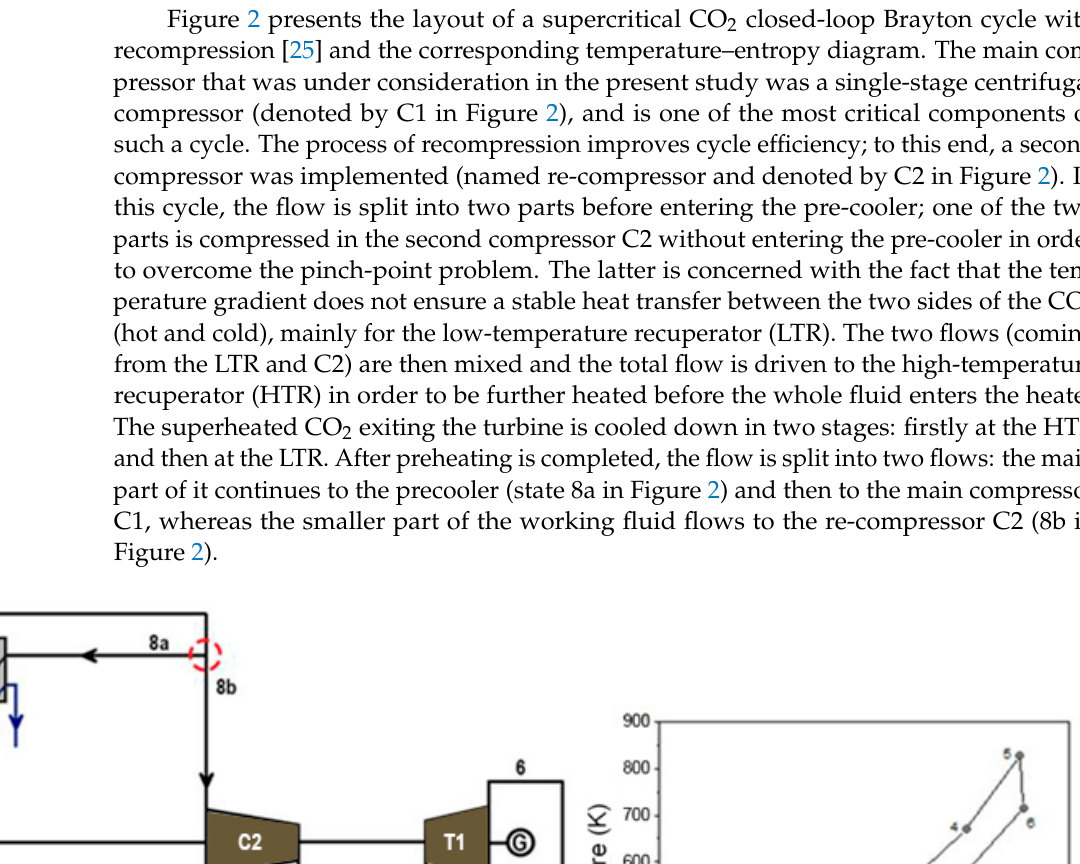
Table 1. Speci fi cations used for the recompression s-CO 2 Brayton cycle.